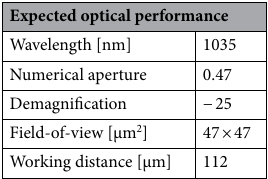
Table 1. Expected optical performance of miniaturized